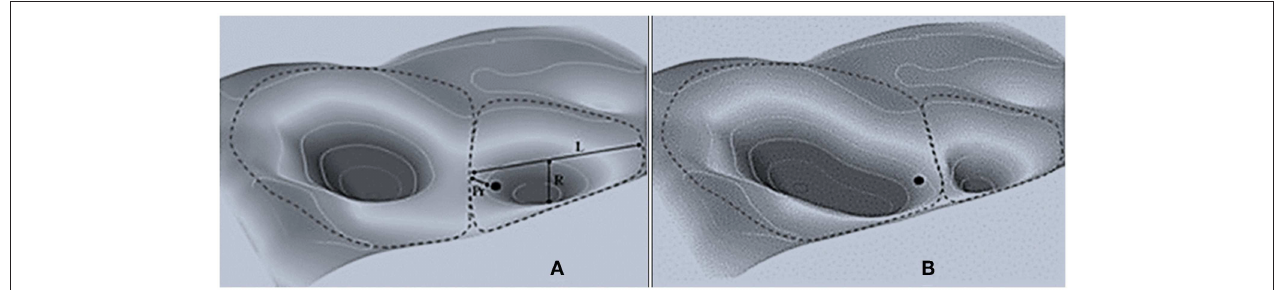
FIGURE 1 | Two landscapes (basins of attraction) and their constituent resilience attributes (from Walker et al., 2004 reprinted with permission). (A) A 3-D stability landscape showing two basins of attraction (dotted lines). In the smaller basin, the current position of the system (black dots) and three aspects of resilience, L, latitude (width of the basin), R, resistance (depth of the basin), and Pr, precariousness (proximity to the basin lip). (B) Changes in the broader landscape can result in contraction of the basin and expansion of an alternate basin. Without changing itself, the system has changed basins of attraction and is precariously positioned for additional